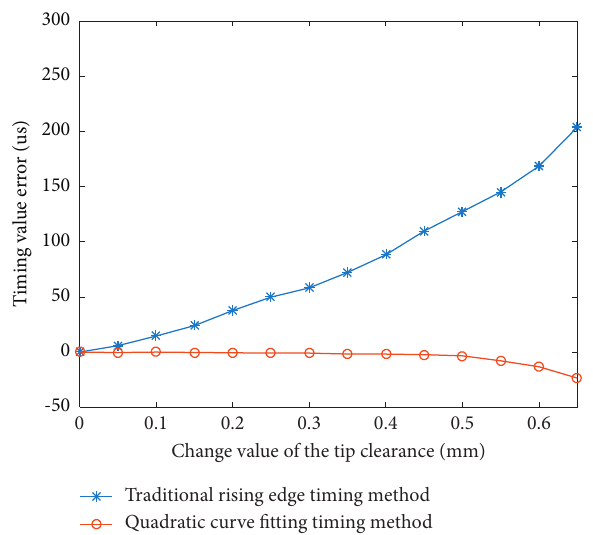
Figure 11: Timing value error comparison curves of two methods.